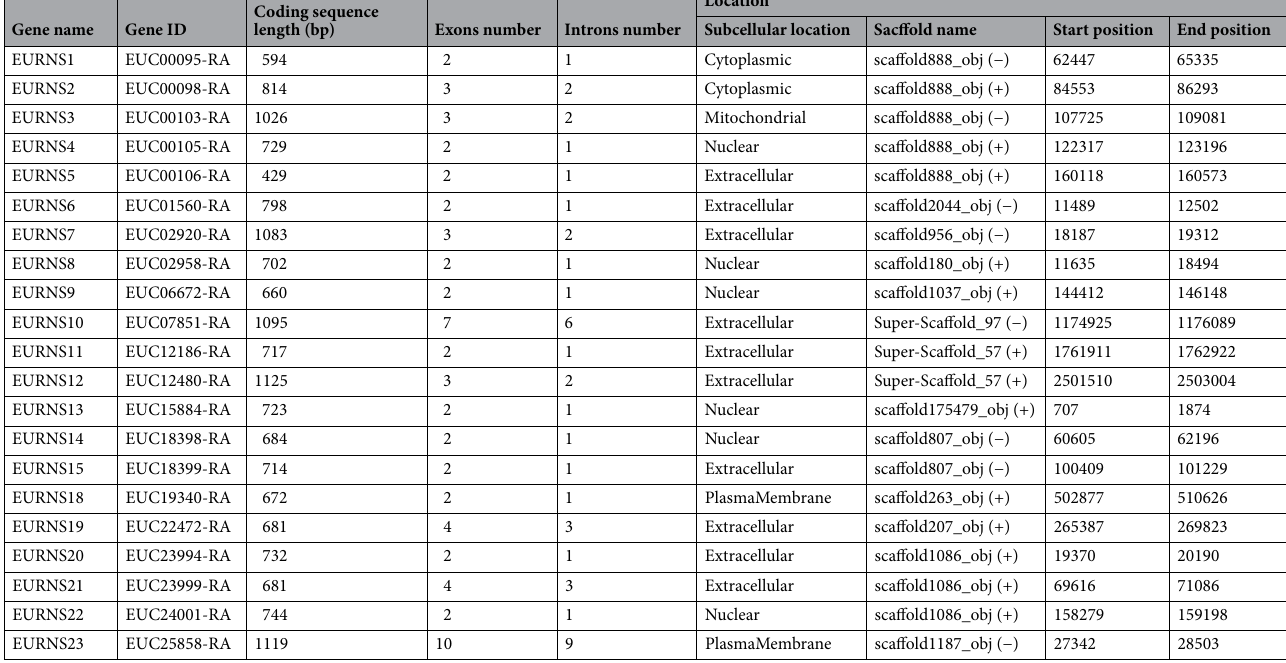
Table 1. Detailed information on EURNS